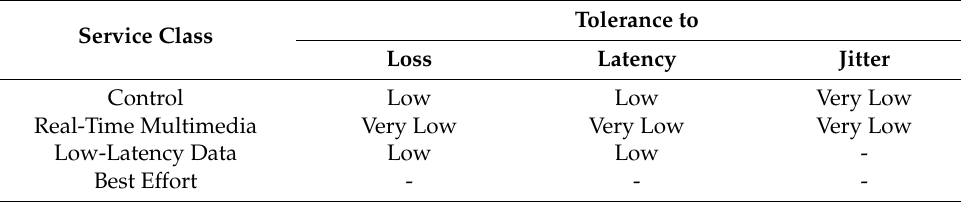
Table 2. Service class